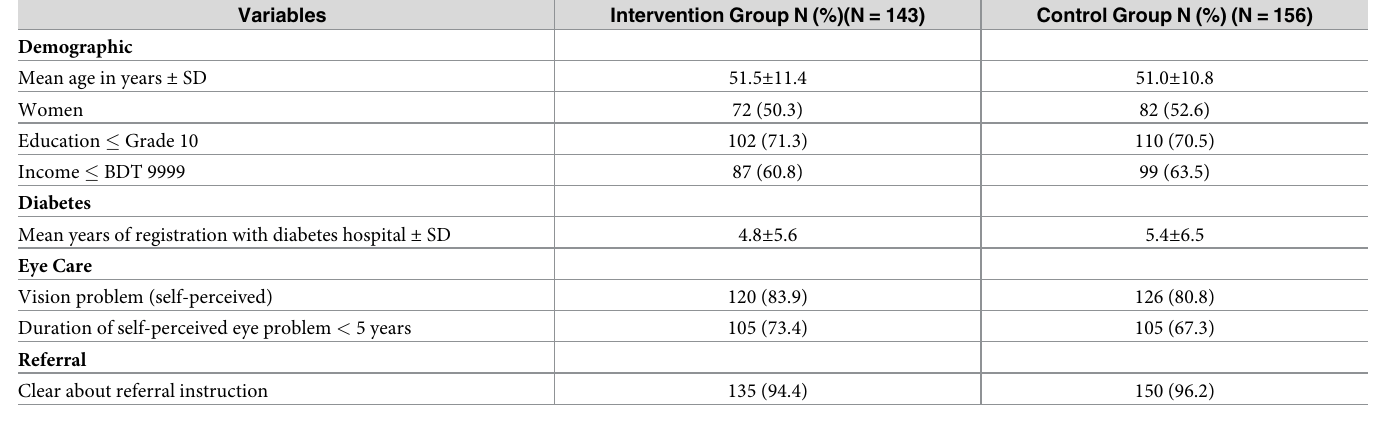
Table 1. Baseline differences between intervention and control group.